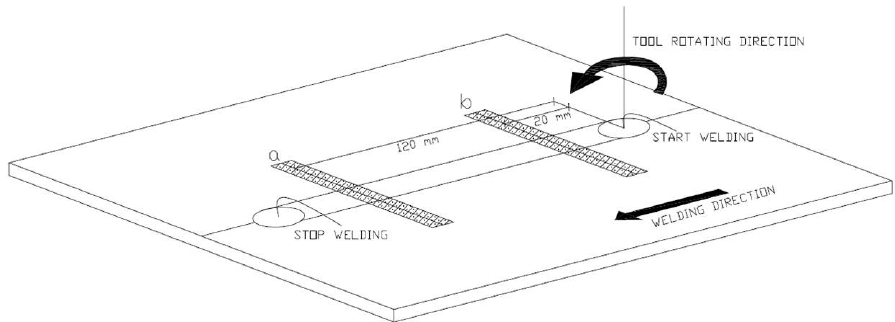
Figure 15. Positioning of the two samples a and b, along the welding direction, used for ANOVA.